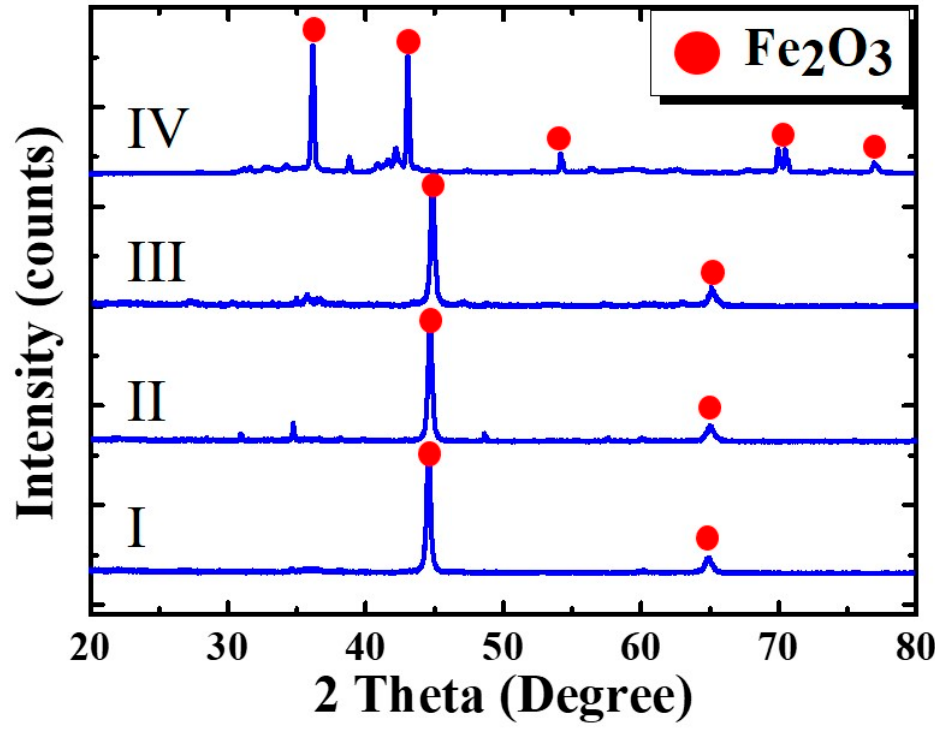
Figure 4. XRD analysis of Fe 2 O 3 crystal phase due to corrosion of the iron cap.